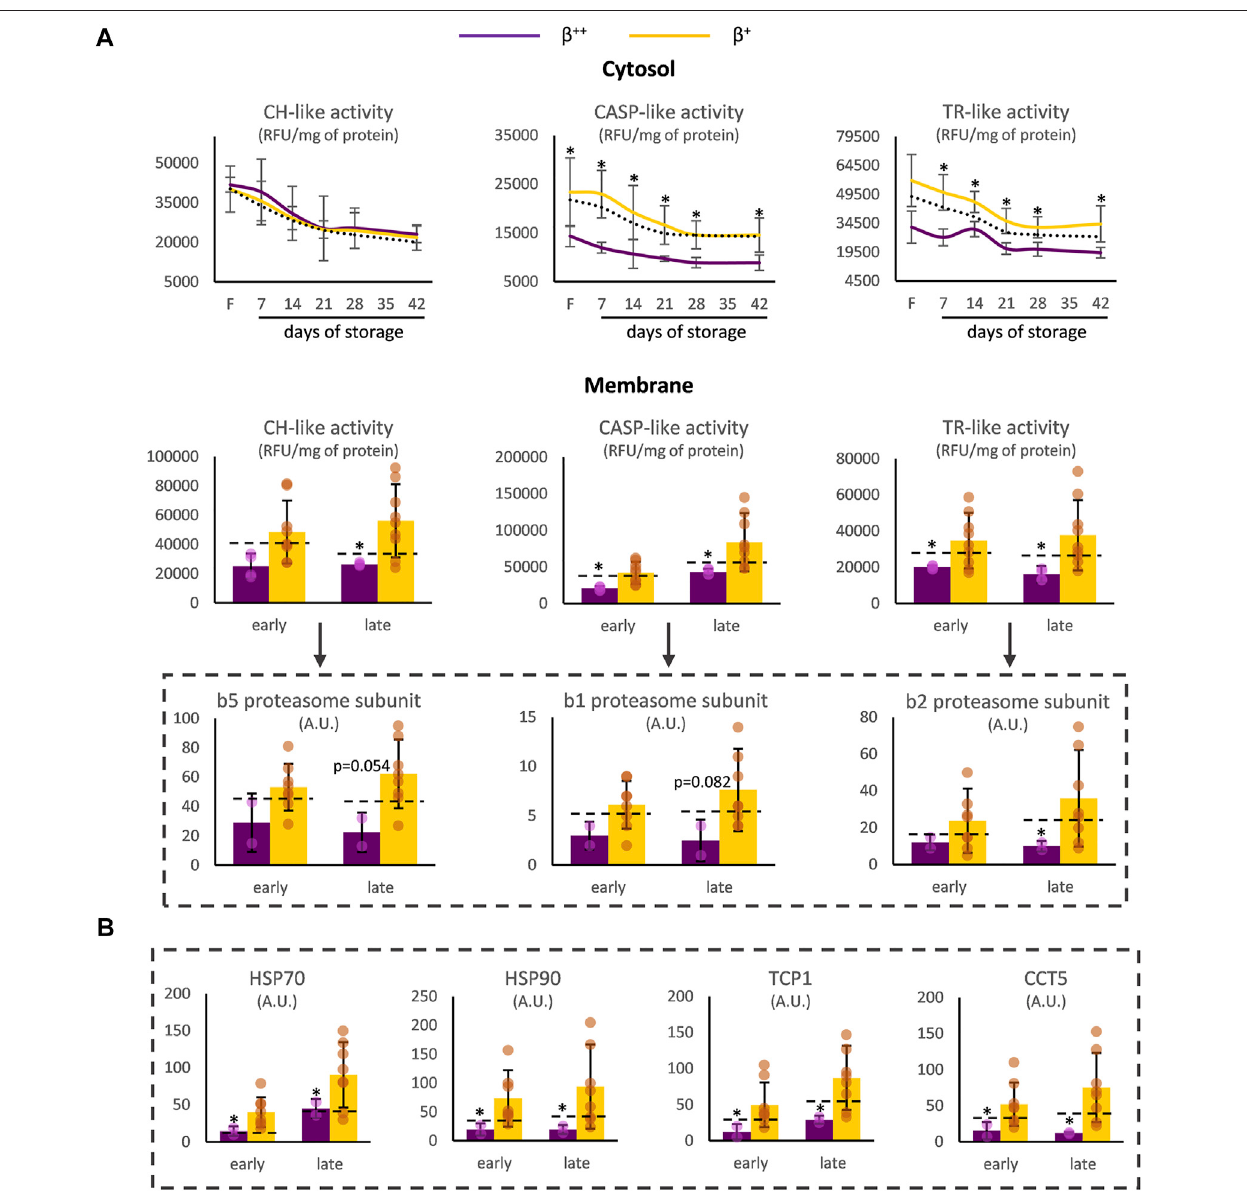
FIGURE 2 | Proteostasis differences between β ++ and β + heterozygotes. (A) Proteasome activity in the cytosol and the membrane and binding of proteasome activitysubunitsonthemembrane. (B) Bindingofchaperoningproteinsonthemembrane.Valuesforaveragecontrolsareshownbydashedlines.Proteomicparameters are shown in dashed boxes ( n = 2 vs. 8, β ++ vs. β + ). (*) p < 0.05. F: freshly drawn blood; CH-like: chymotrypsin-like, CASP-like: caspase-like, TR-like: trypsin-like proteasome activities; RFU: relative fl uorescence units; A.U, arbitrary units; HSP: heat shock protein; TCP1: T-complex protein one; CCT: T-complex